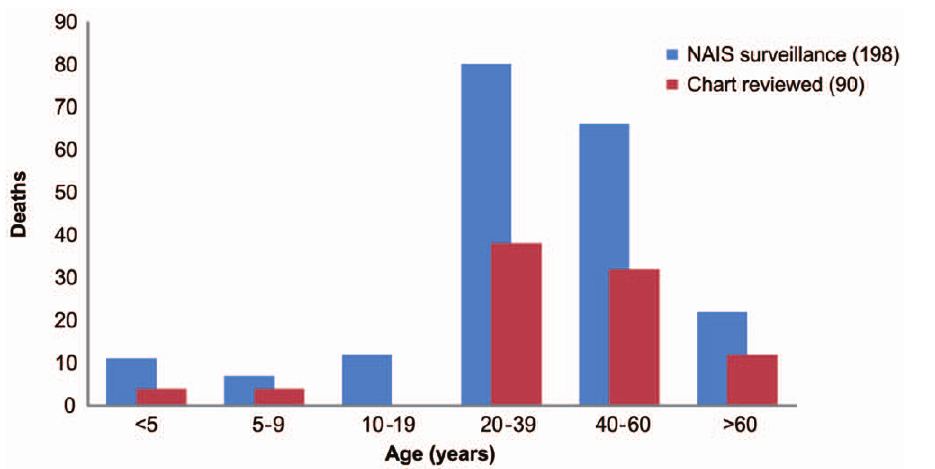
Figure 2. Age distribution of influenza A (H1N1)pdm09 deaths. Detailed legend: Age distribution of influenza A (H1N1)pdm09 deaths reported to the National Avian Influenza Surveillance (NAIS) system, Bureau of Epidemiology, Ministry of Public Health, Thailand and those for whom medical charts were available for review - May 2009-January 2010. Bars represent number of deaths for each age group (Figures are in a separate file).